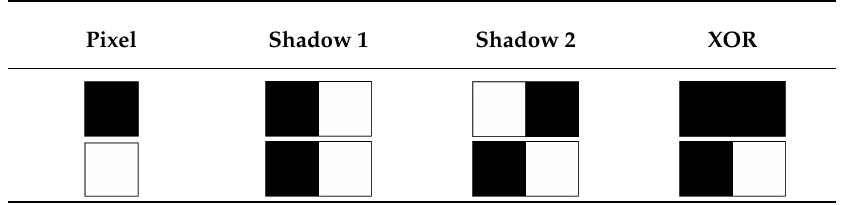
Table 1. The encoding and decoding process of the shadows in a (2, 2)-OR-based ( k , n ) -VC (OVC)